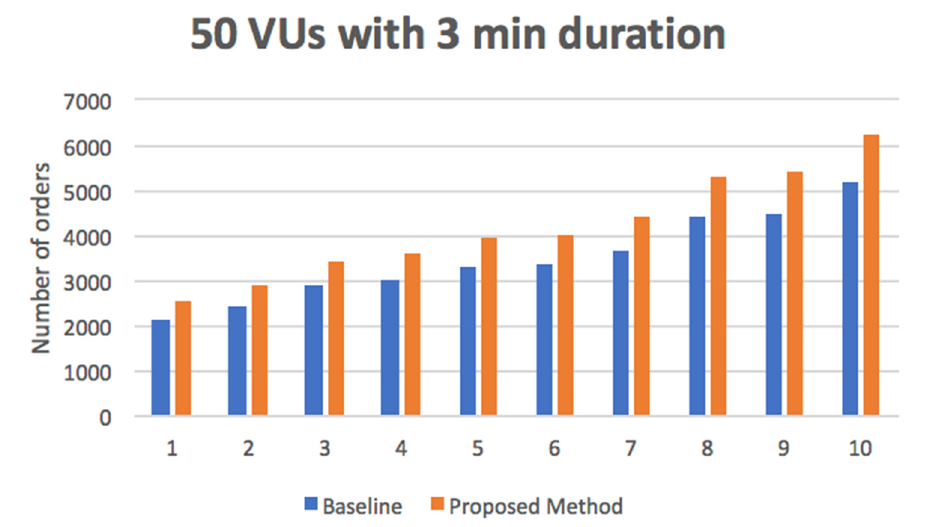
Figure 21. Load Testing—15 virtual users with 3 min duration.